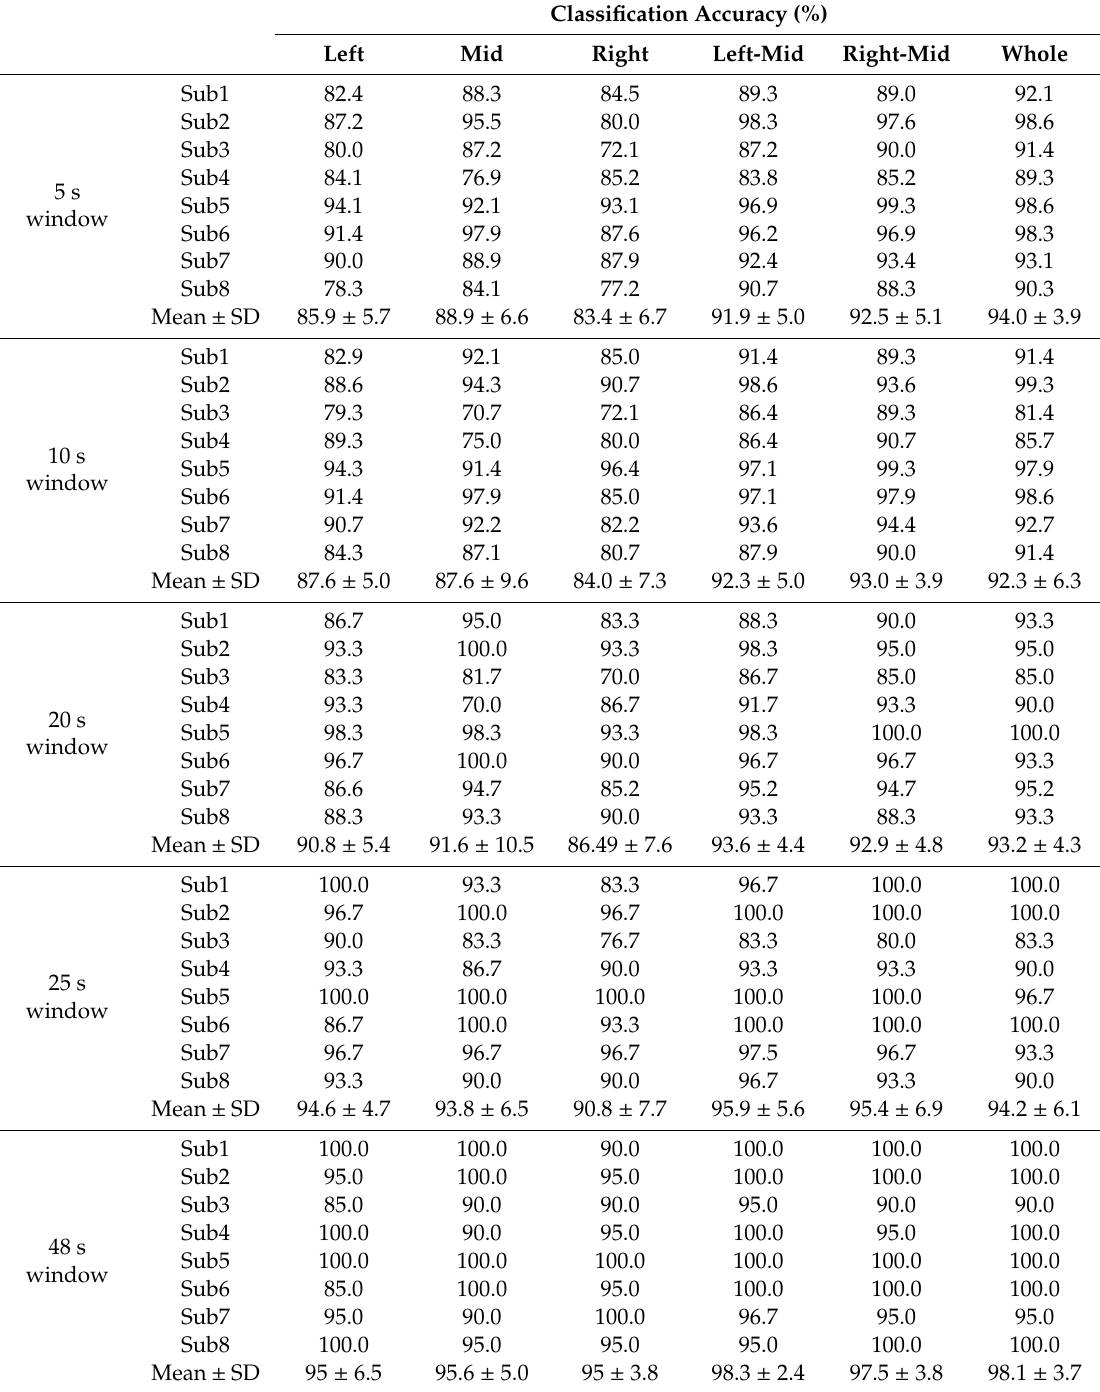
Table 1. Classification accuracies along with means and standard deviations (SDs) across all subjects for each location on the